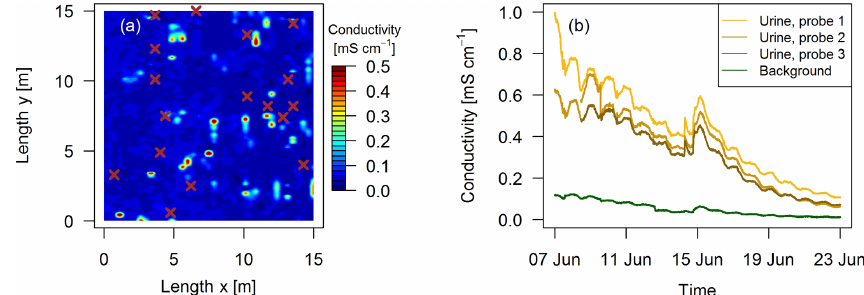
Figure 3. (a) Measured conductivity within a quadratic 15m × 15m intensive observation area on the 3 October 2016 in system G. High val- ues (>0.15mScm − 1 ) indicate urine patch locations and brown crosses indicate observed dung pats. (b) Conductivity measured continuously during a field experiment in 2017 with four GS3 sensors.